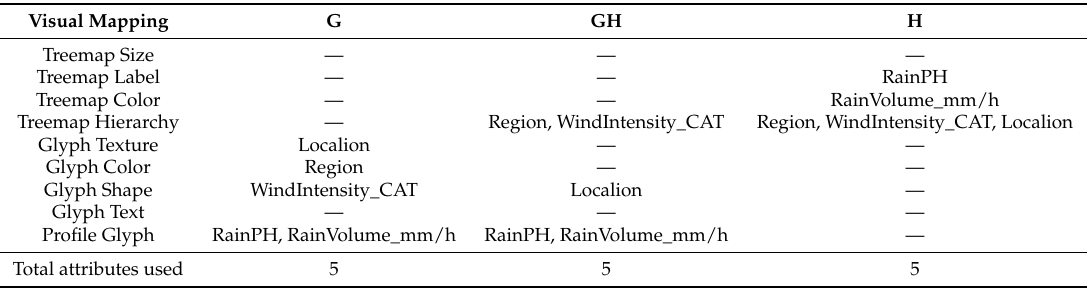
Table 4. Attributes distribution in the scenarios G, GH, and H on realizing the task 4. The user task used the same attributes, differing on the use of visual